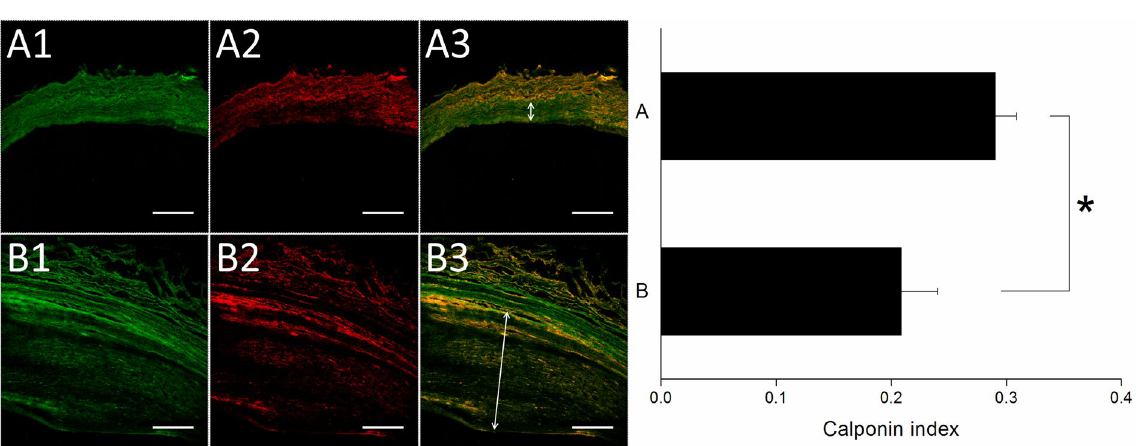
Figure 12. Calponin immunostaining (red) of group A and group B was shown. Less degree of positive labeling with calponin was shown on group B after 24 weeks. The double arrow also depicts tunica media. (Scale bar = 150 μ